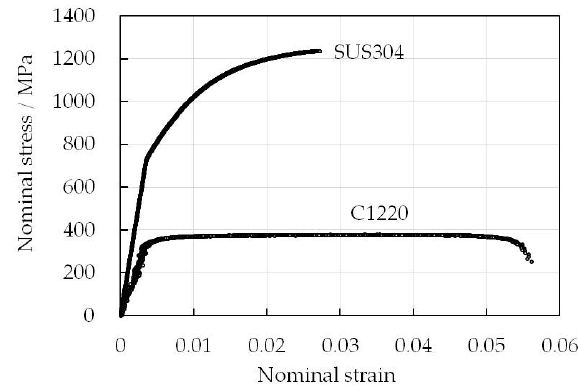
Figure 5. Stress–strain curves obtained from tensile test results of microtubes used.